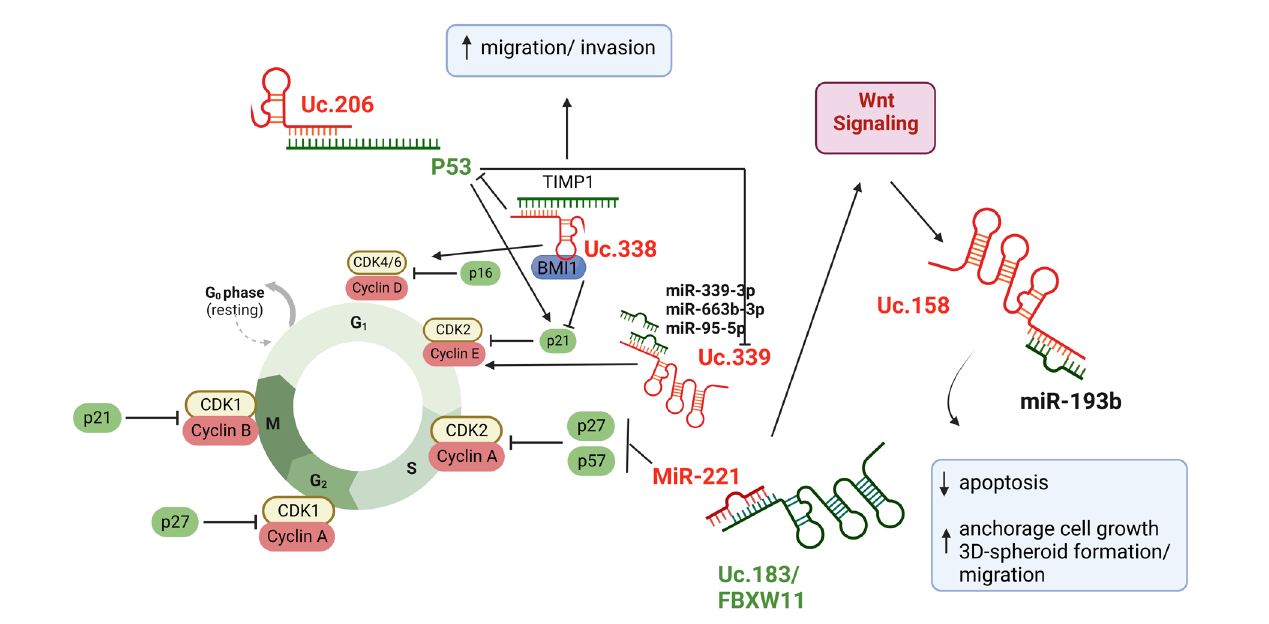
Figure 3 – Mechanism of action of Uc.158, Uc.183, Uc.206, Uc.338, and Uc.339. Green molecules meaning low expression and red meaning high expression. Created with